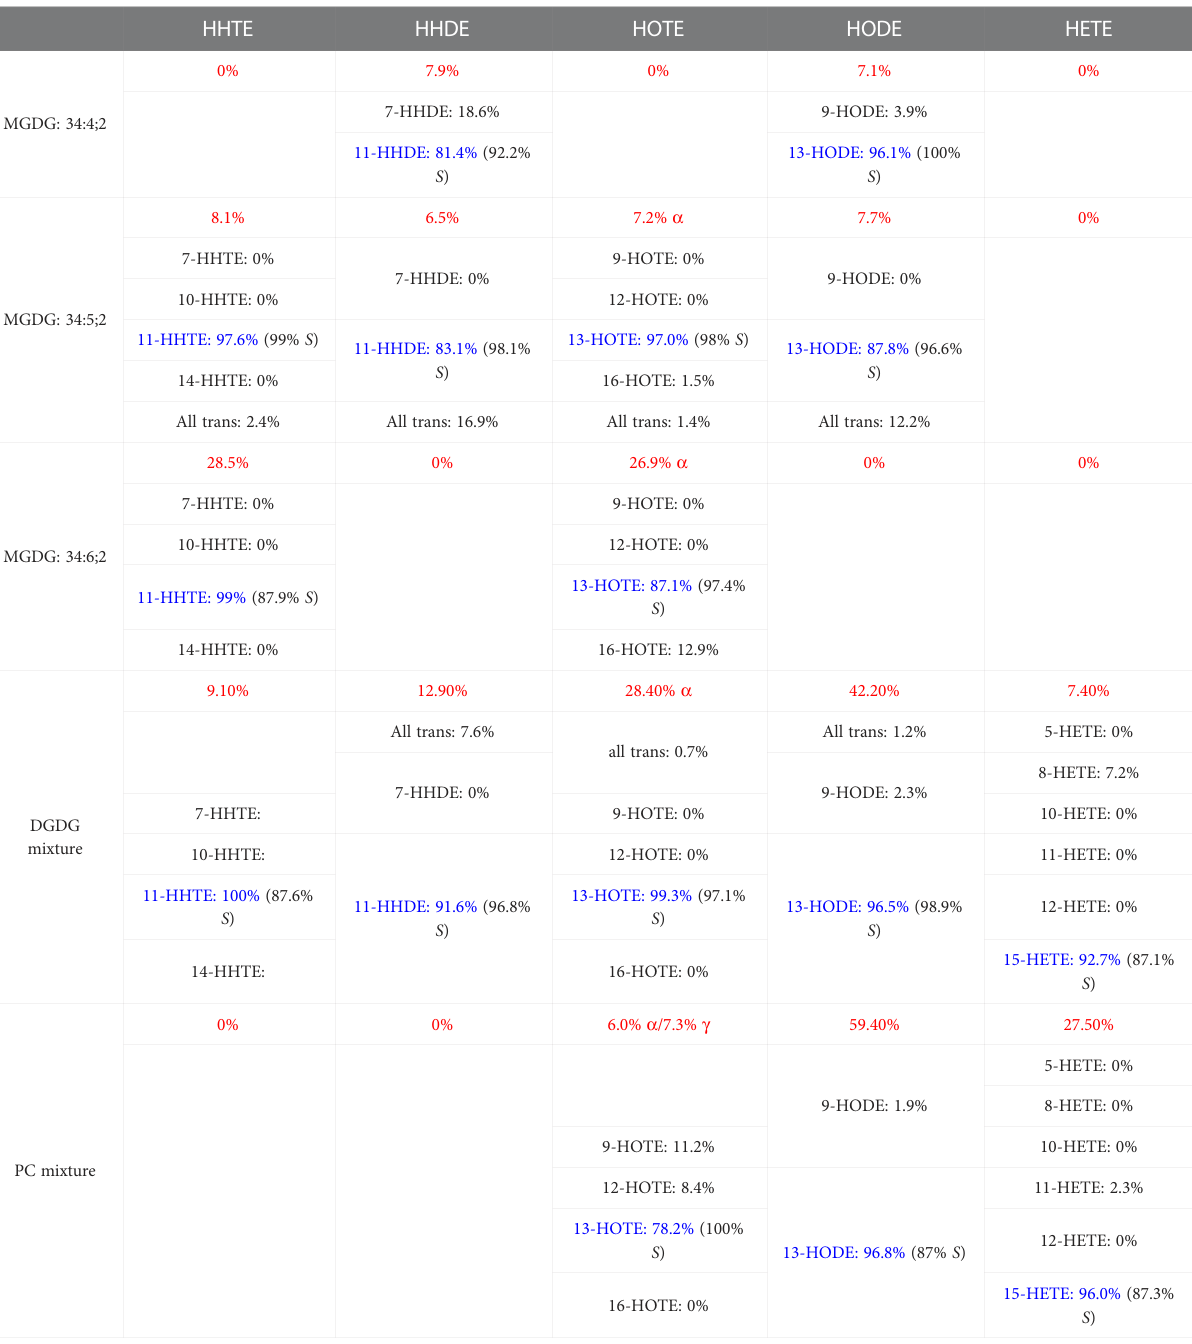
TABLE 1 All oxidation products of MGDG, DGDG and PC isolated from L. incisa after LiLOX reaction. HHTE HHDE HOTE